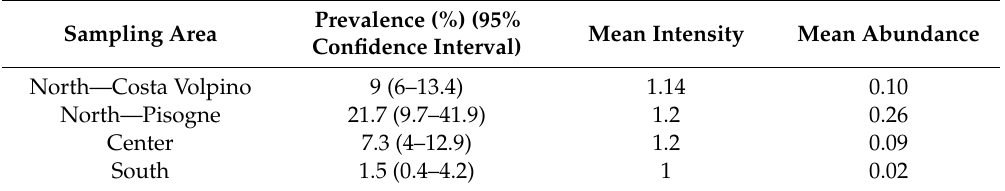
Table 2. Sampling area, prevalence (%), mean intensity, and mean abundance of plerocercoid larvae. Sampling